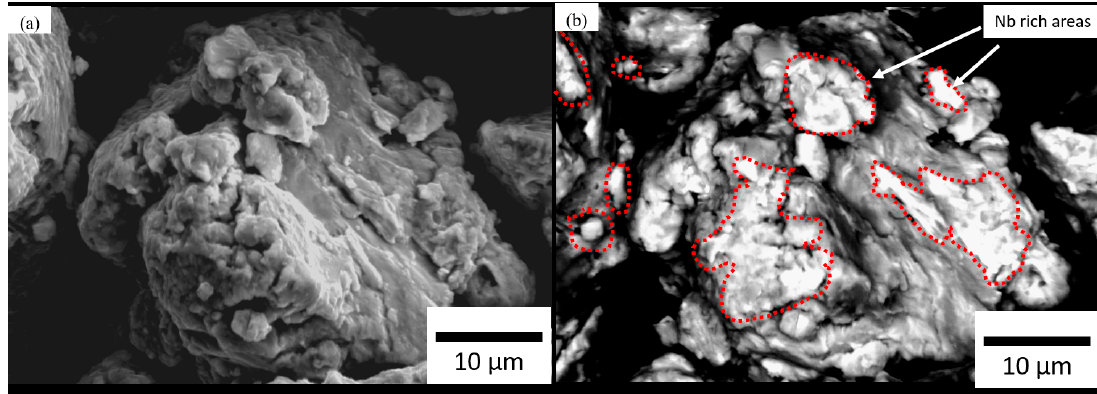
Figure 4. ( a ) Secondary Electron (SE), and ( b ) Backscattered Electron (BSE) micrograph of 72 ks mechanically alloyed Ti-244